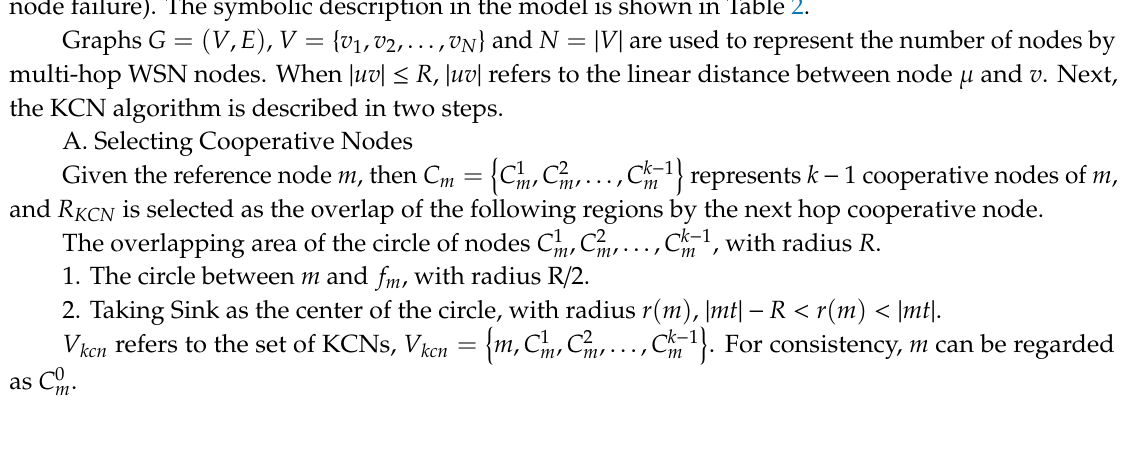
Figure 3. f and k effect on end-to-end reliability. Figure 3. f and k e ff ect on end-to-end